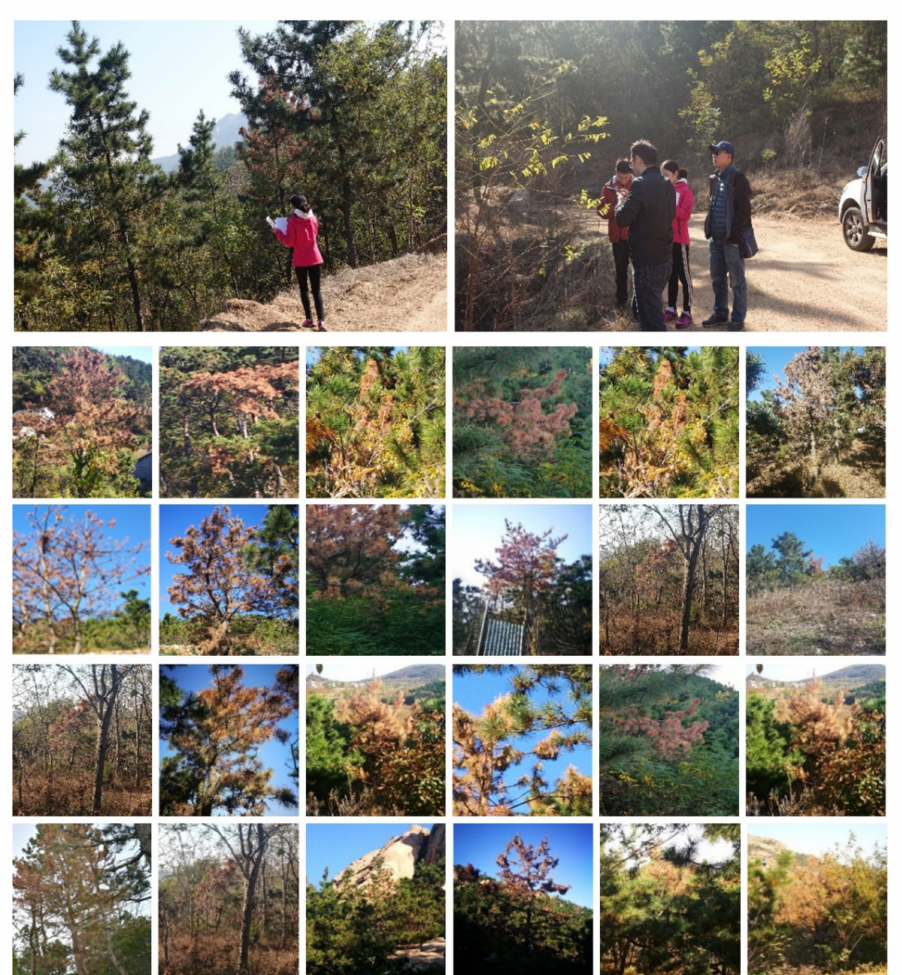
Figure 2. Researchers conducting field survey of PWD-infected pines (first row) and images of infected pines (second to fifth